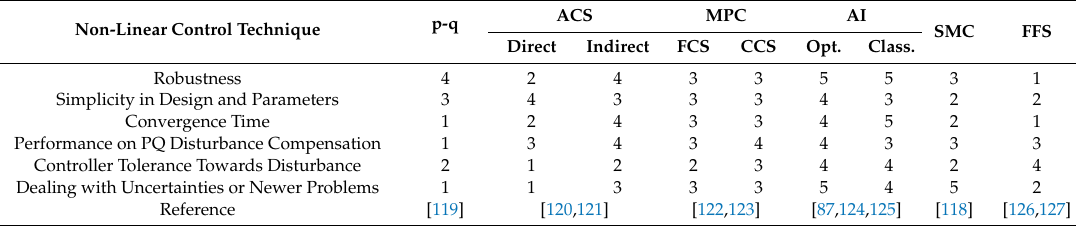
Table 4. Performance analysis summarization of the non-linear control techniques (PWM and FFS). Non-Linear Control